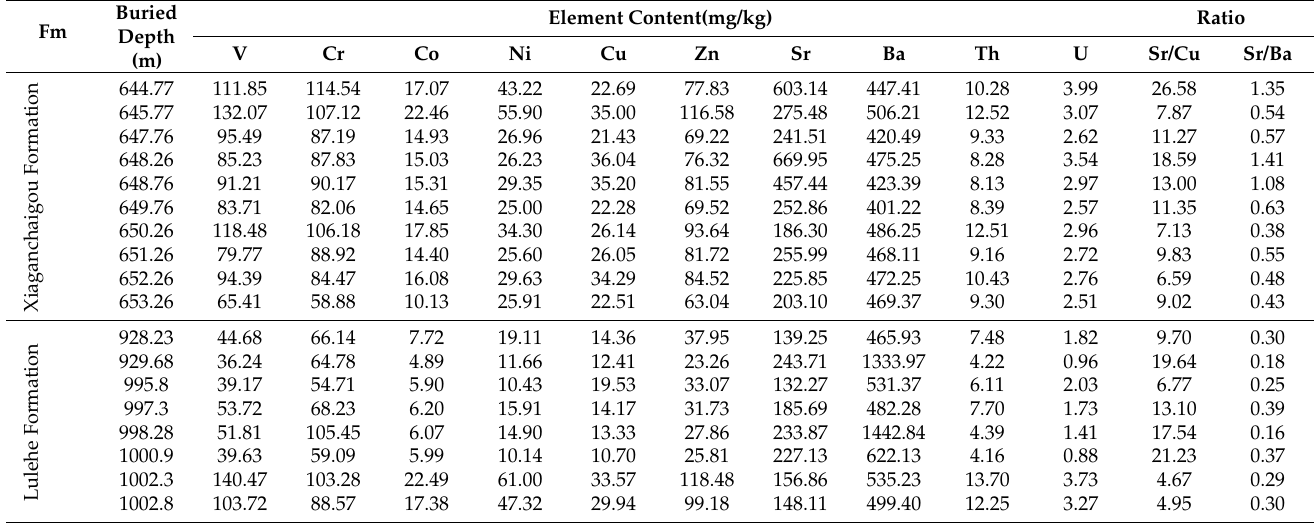
Table 3. Trace element contents of the Paleogene in the Pingtai area.